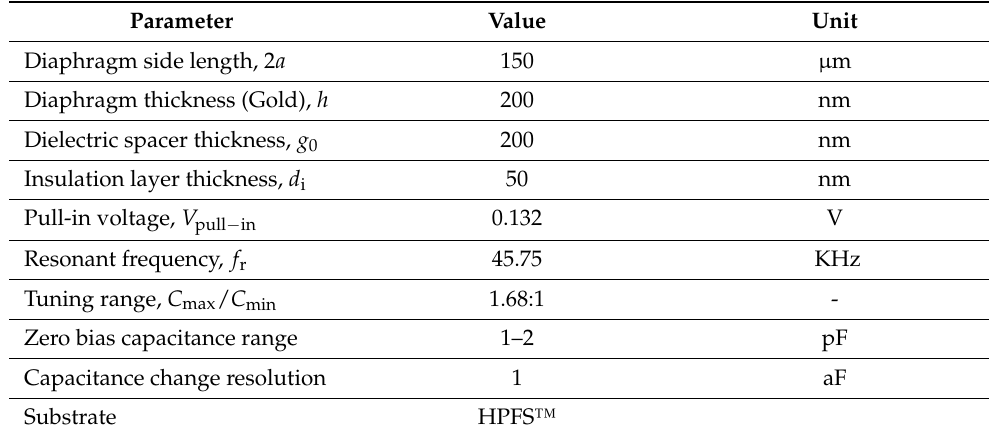
Table 3. MEMS capacitor design specifications [25].